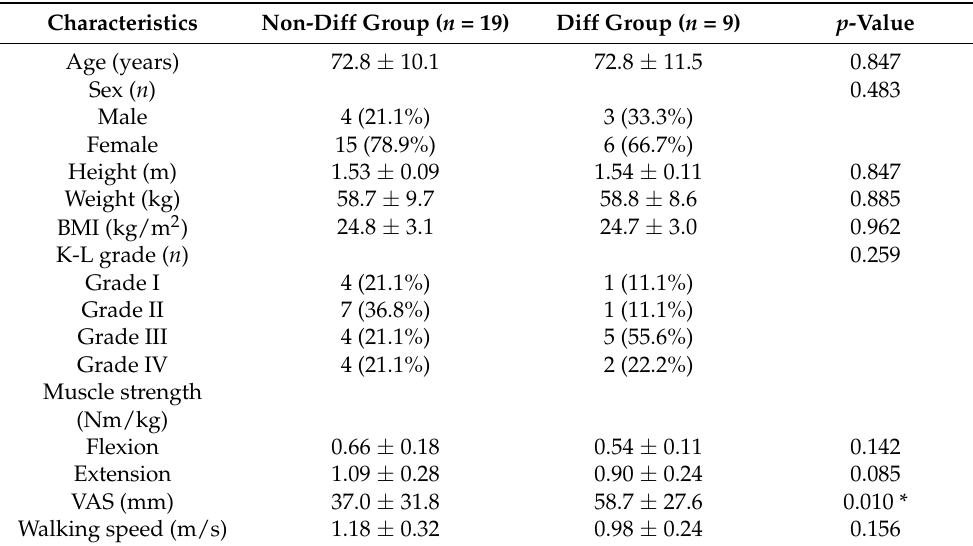
Table 1. Characteristics and outcome measures of the groups with walking difficulty (Diff) and without walking difficulty